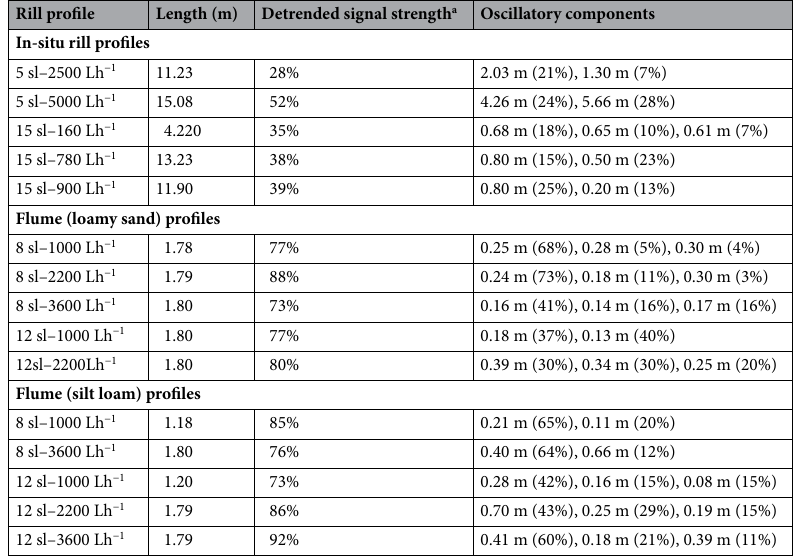
Table 1. Experimental rill-bed profiles and signal processing with singular spectrum analysis. a The percent of total variation in the detrended rill-bed elevation profile accounted for by the detrended